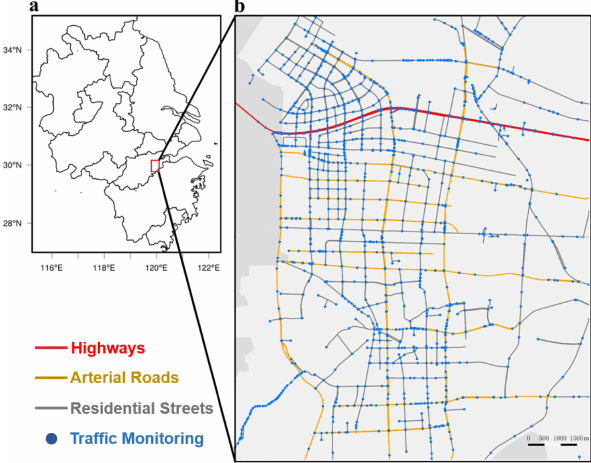
Figure 2. Comprehensive traffic monitoring network in Xiaoshan District. (a) Xiaoshan District (the red rectangle) is located in the hinterland of the YRD in China. (b) Comprehensive traffic moni- toring achieves full coverage over Xiaoshan District. Each dot rep- resents a set of comprehensive traffic monitoring platforms that can recognize traffic fluxes, vehicle-specific speed, categories, and li- cense plates. The gaps between two sets, ranging from 10m to 1km, determine the spatial resolution of the road and emission map. The entire road network over Xiaoshan District is divided into 1894 road segments. Such road segments are divided into three road classes: highways (red lines), arterial roads (yellow lines), and residential streets (grey lines). Map data © 2021, Gaode